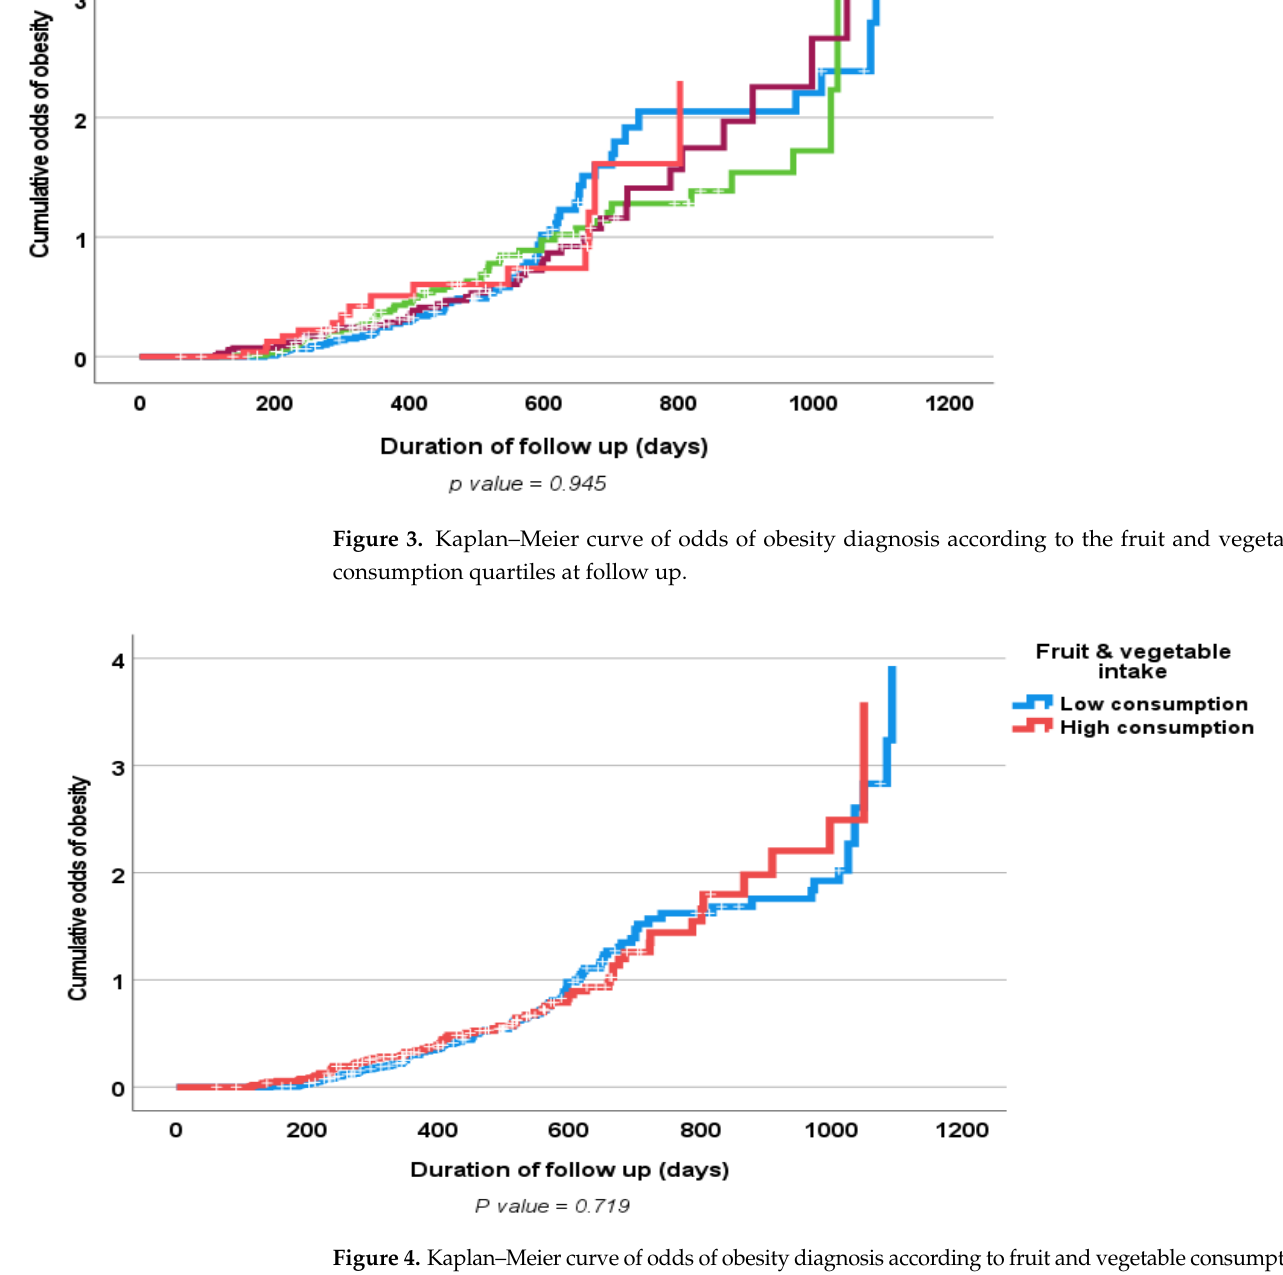
Figure 4. Kaplan–Meier curve of odds of obesity diagnosis according to fruit and vegetable consumption (high consumption > 3.7 servings/day vs. low consumption ≤ 3.6 servings/day) at follow up.